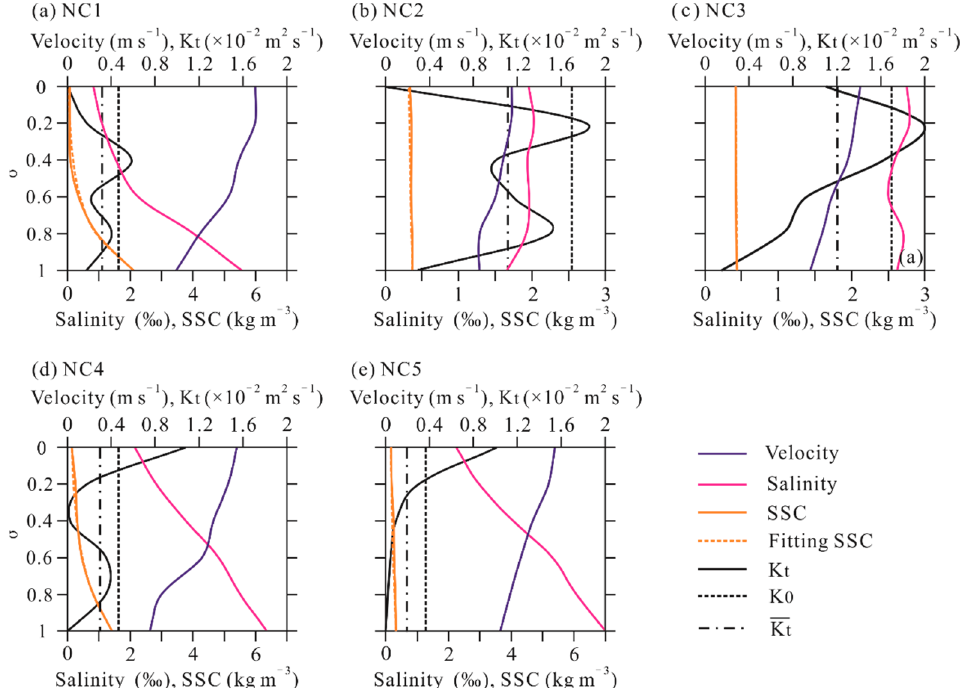
Figure 12. Vertical profiles of the velocities (m s − 1 ), salinities (psu), measured and fitting SSC (kg m − 3 ), eddy diffusivities 𝐾 (cid:3047) (m 2 s − 1 ) and theoretical value of eddy diffusivities 𝐾 (cid:2868) (m 2 s − 1 ) of NC1 to NC5 stations ( a – e ) at the 11th hour after the beginning of observation. Here, 𝜎 is relative depth, 𝜎 = −𝑧/ℎ ( 𝜎 = 0 is the surface and 𝜎 = 1 the bottom).